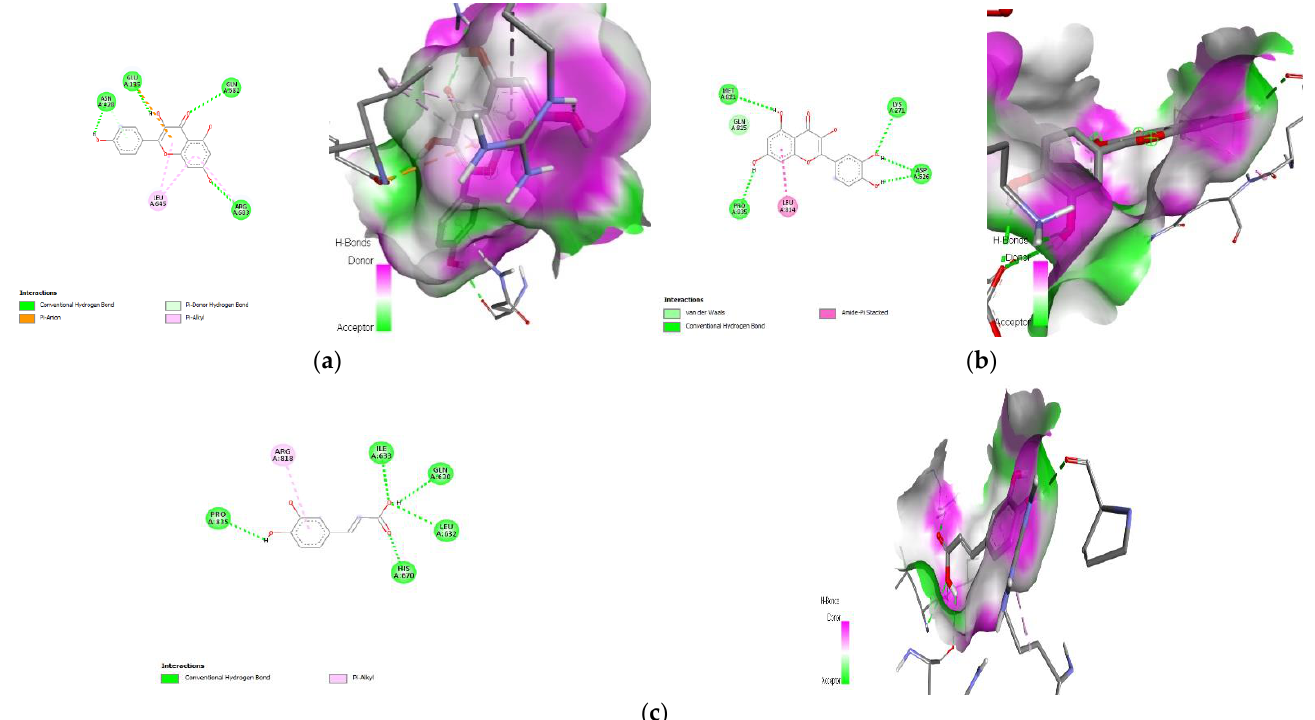
Figure 13. Lead compounds and their interaction with PI3K at the molecular level. ( a ) Kaempferol; ( b ) quercetin; ( c ) caffeic acid.